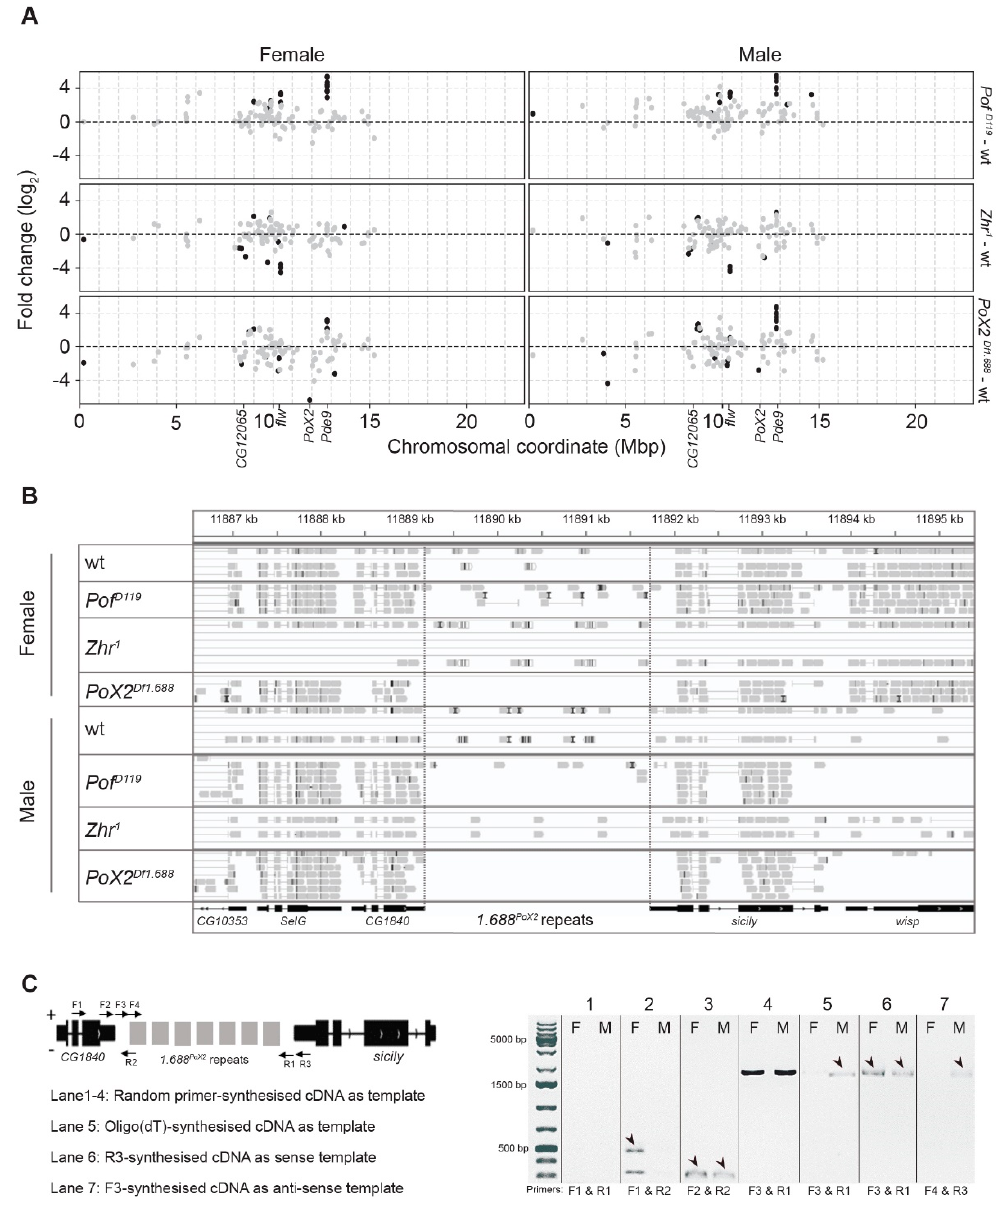
Figure 6. The 1.688 satellite expression analysis across the X-chromosome and at the PoX2 locus. ( A ) Differential expression and X-chromosome distribution of 1.688 satellite blocks. Dots are coloured black if significant ( P adj ≤ 0.05) and grey otherwise. The 1.688 PoX2 locus (indicated) is located at approximately 12 Mbp. ( B ) An Integrative Genomics Viewer screenshot with aligned reads at the PoX2 locus in the different genotypes. Note that no reads map to the 1.688 region between CG1840 and sicily in PoX2 Df1.688 mutant females and males. ( C ) Reverse transcription PCR using the indicated primer combinations confirm the short read-through and long non-coding RNA transcription from the 1.688 satellite at the PoX2 site in wild type. In the gel electrophoresis panel, F and M indicate females and males, respectively.